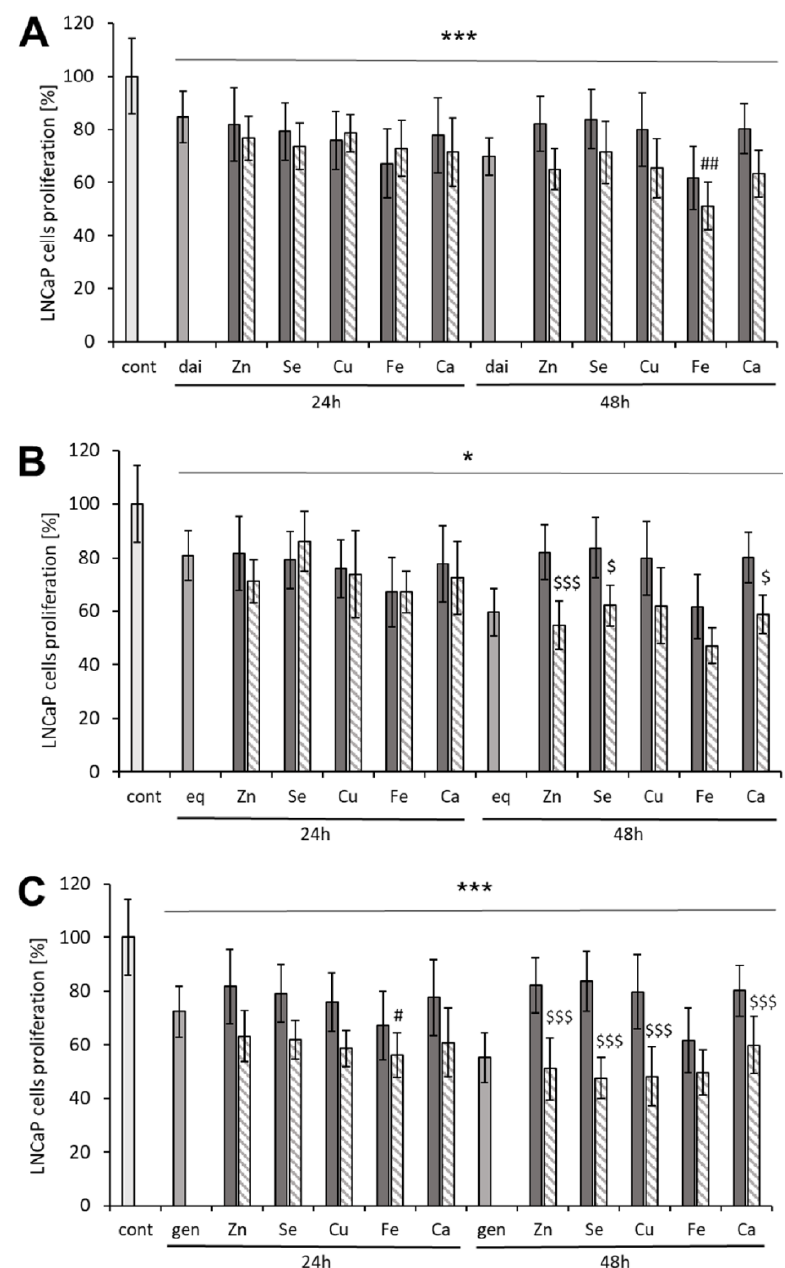
Figure 1. The anti-proliferative effects of (micro)elements and isoflavones on LNCaP cells. The solid bars represent the effects of single agents and the patterned bars the effects of combinations of ( A ) daidzein (dai), ( B ) equol (eq) and ( C ) genistein (gen) with designated elements. * p < 0.05, *** p < 0.001 vs. control; # p < 0.05, ## p < 0.01 vs. 10 µM isoflavone; $ p < 0.05, $$$ p < 0.001 vs. respective element.